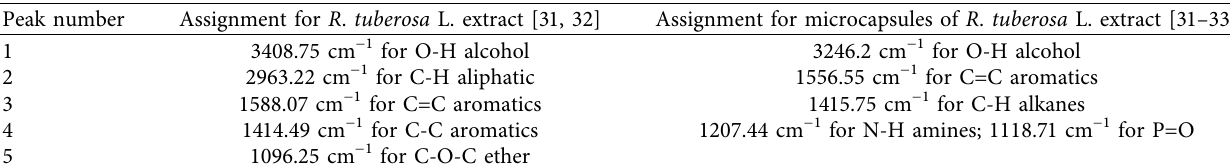
Figure 1: FTIR spectra of the (a) R . tuberosa L. extract. (b) Microcapsules of R . tuberosa L. extract prepared in pH 4, 90 min stirring time, and 0.1% (w/v) chitosan. Table 2: Assignment of the FTIR